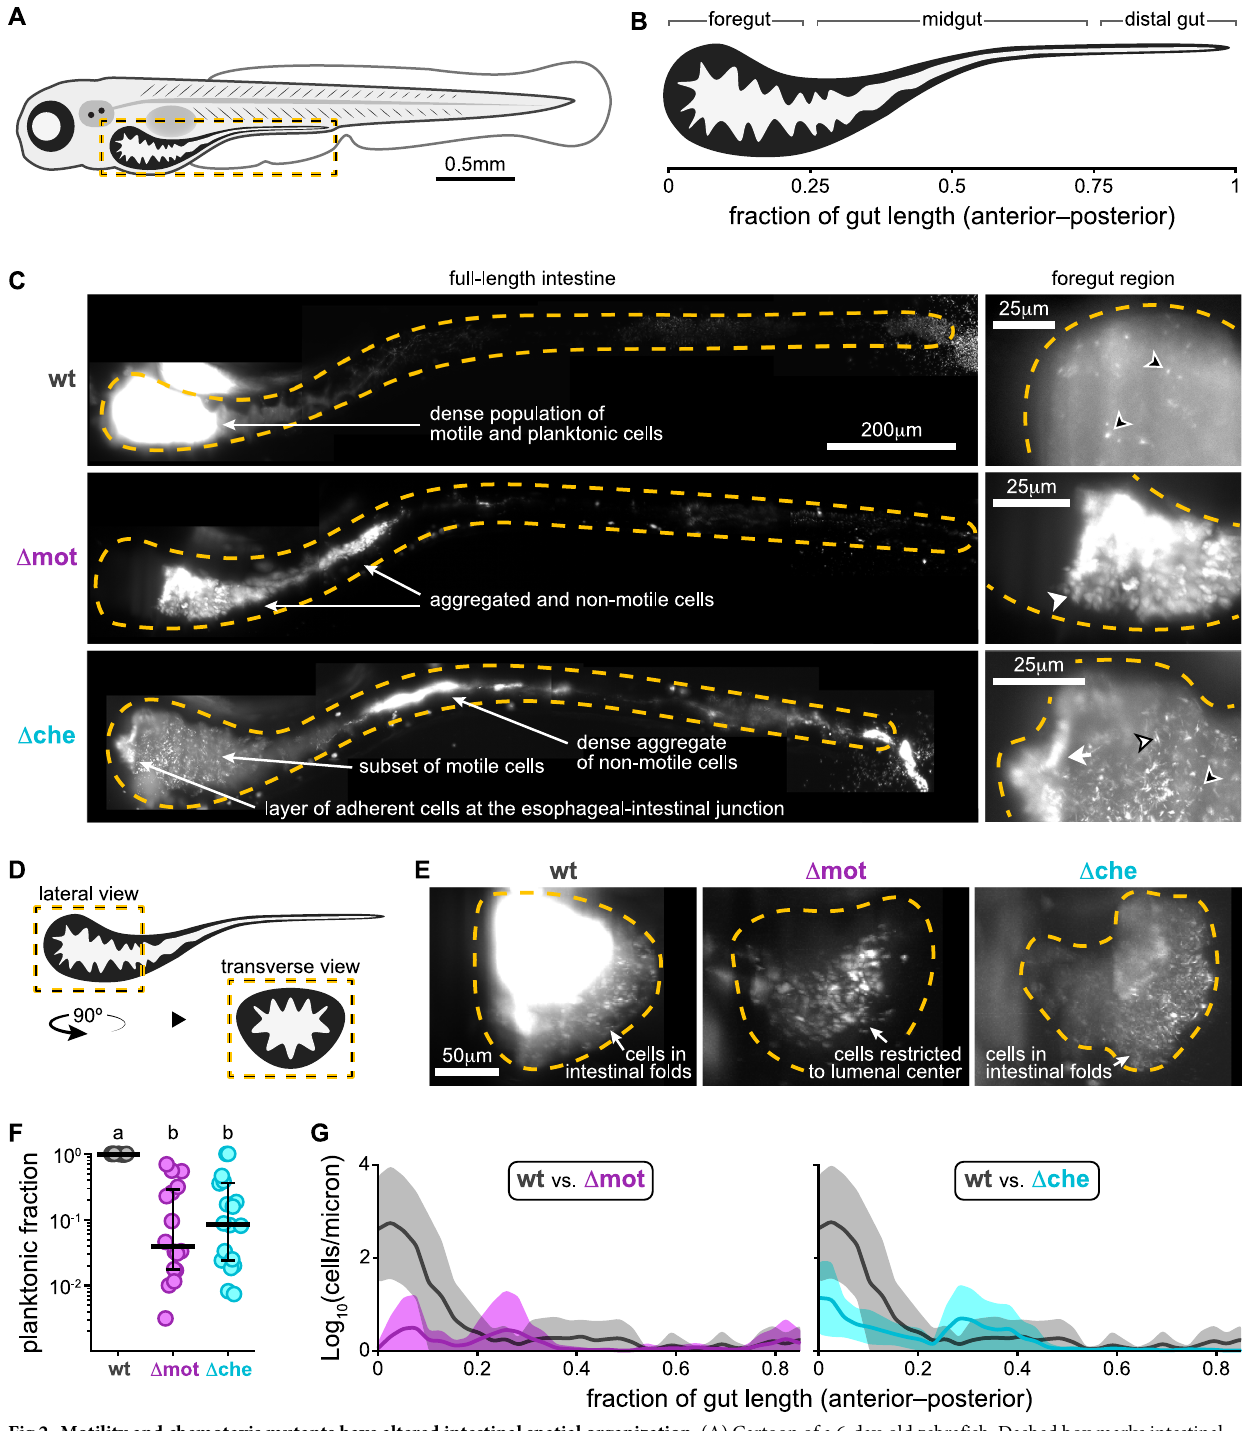
Fig 2. Motility and chemotaxis mutants have altered intestinal spatial organization. (A) Cartoon of a 6-day-old zebrafish. Dashed box marks intestinal region imaged by LSFM. (B) Anatomical regions of the larval zebrafish intestine. (C) Maximum intensity projections acquired by LSFM showing the spatial organization of wt Vibrio (top), Δ mot (middle), and Δ che (bottom) within the intestine. Top right inset shows a zoomed-in view of wt Vibrio cells in a separate fish that was colonized with a 1:100 mixture of green- and red-tagged variants so that the cellular organization of the dense Vibrio population could be discerned. The dilute channel (green) is shown. Dashed lines mark approximate intestinal boundaries. Open arrowheads: single bacterial cells; solid arrowheads: small aggregates; tailed arrowheads: large aggregates. Arrowheads with a black stroke mark swimming cells, which appear as comet-like streaks. (D) Cartoon showing the intestinal region pictured in panel E. (E) Maximum intensity projections acquired by LSFM showing transverse view of the